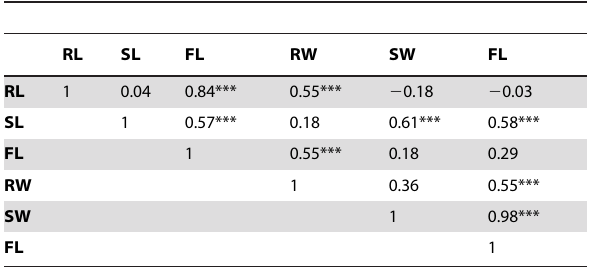
Table 6. Correlation coefficients ( r ) between pairs of traits of seedlings at seedling stage under